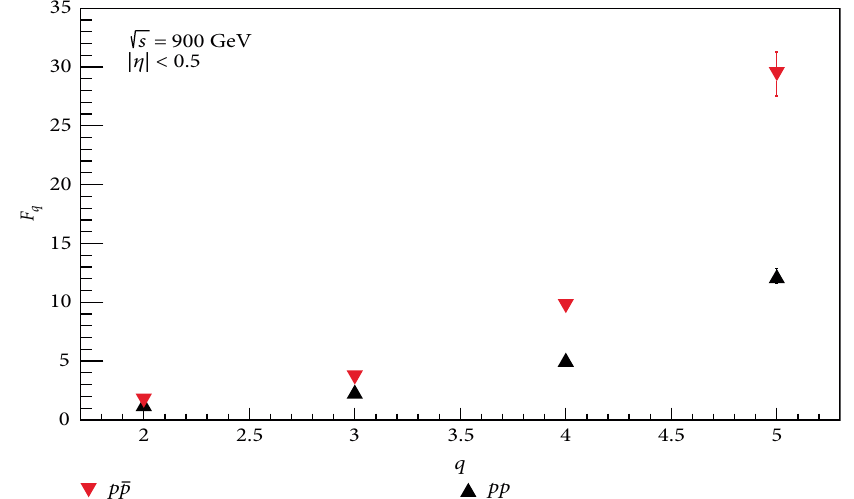
Figure 15: Comparison of normalised factorial moments for